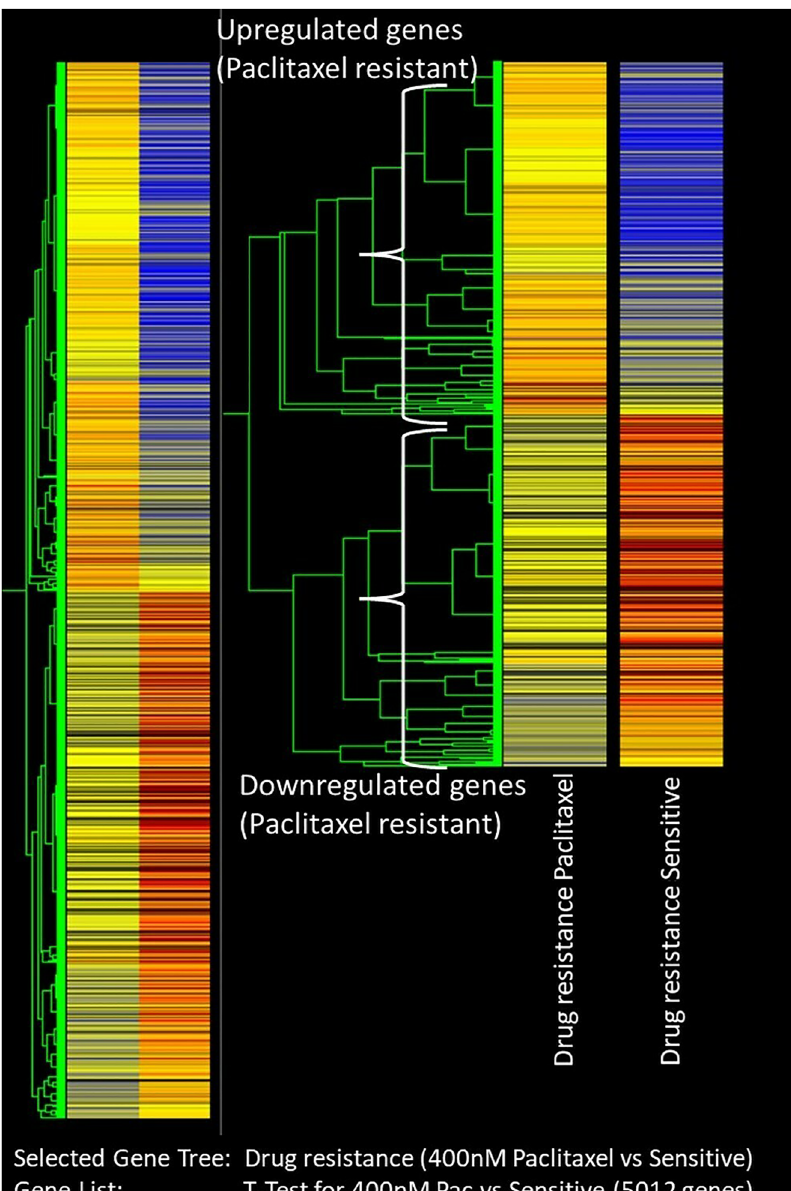
Figure 1: Gene tree constructed during the